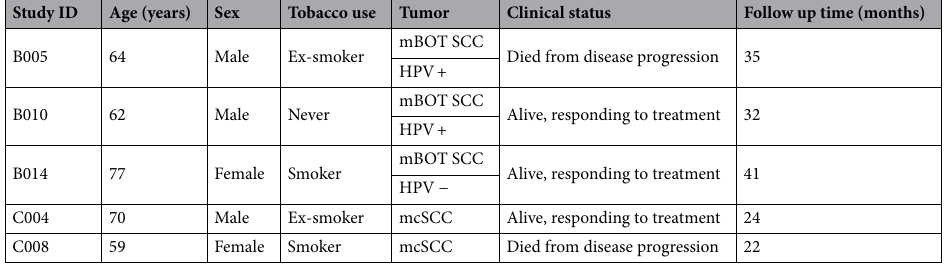
Table 1. Clinicopathological characteristics of the cohort. mBOT SCC metastatic base of tongue squamous cell carcinoma, mcSCC metastatic cutaneous squamous cell